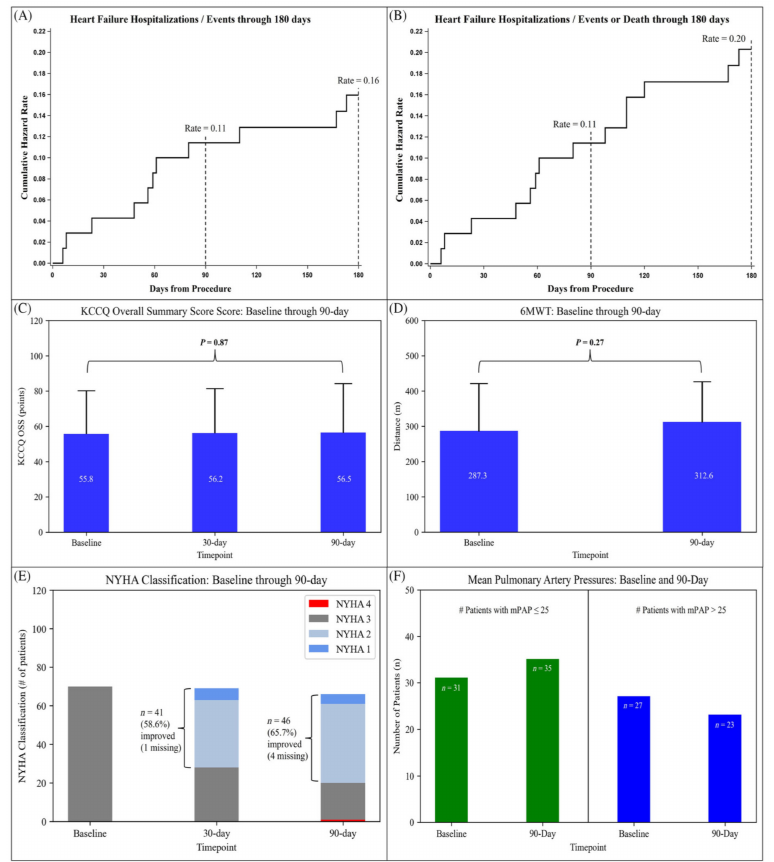
Figure 7. Summary of the results of the SIRONA 2 study. ( A ) Cumulative hazard rate curve through 180 days for HF hospitalizations, HF treatments in a hospital day-care setting, or urgent outpatient clinic HF visits. ( B ) Cumulative hazard rate curve through 180 days for HF hospitalizations, HF